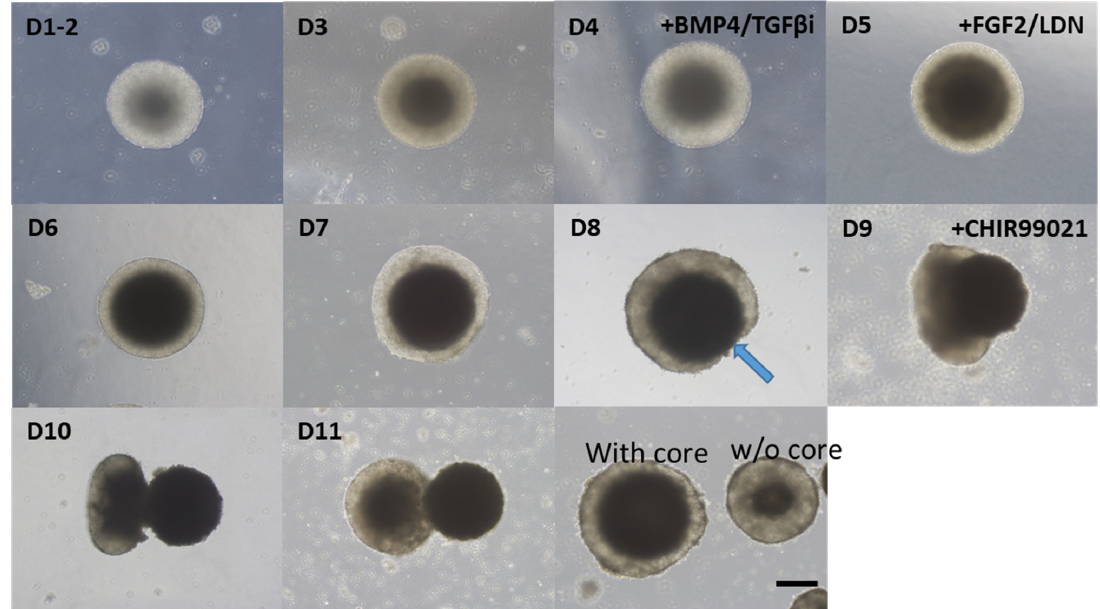
Figure 2. Enucleation of the central core during the maturation phase. Serial changes in a representative EB from day 1 (D1) to day 11 (D11) are shown. During the development of the organoid, the cellular density of the central part of the EB gradually increased, as indicated by the gradual darkening of the central part. Around day 8 (D8), thinning of the peripheral region was observed (arrow). Then, the central part protruded gradually from day 9 (D9) to day 11 (D11). Eventually, this central part (core) detached from the parent EB and formed a separate EB. Some EBs matured without undergoing enucleation. Enucleated EBs were smaller than nonenucleated EBs. Scale bar indicates 200 µm.